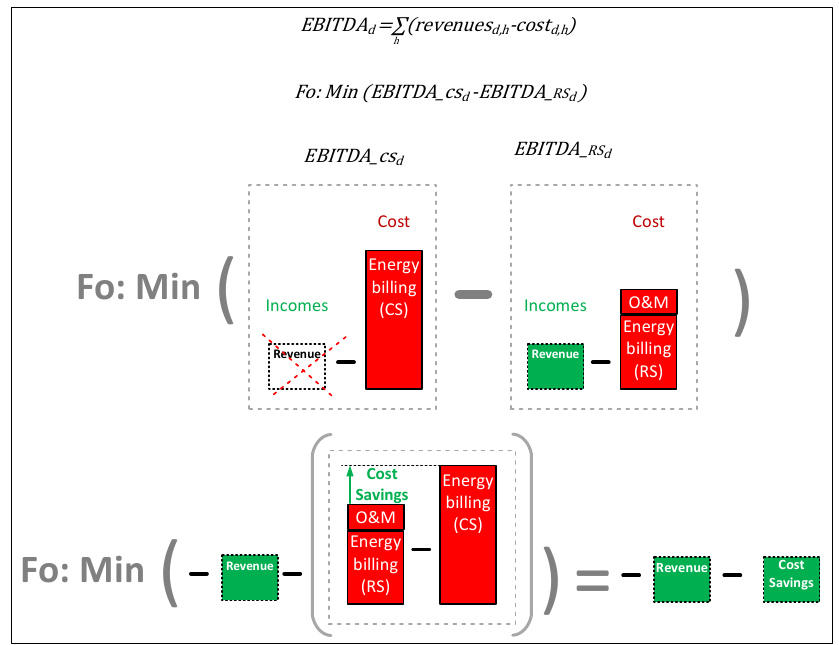
Figure 17. Objective function and economic results disaggregation. Source: self-elaboration.